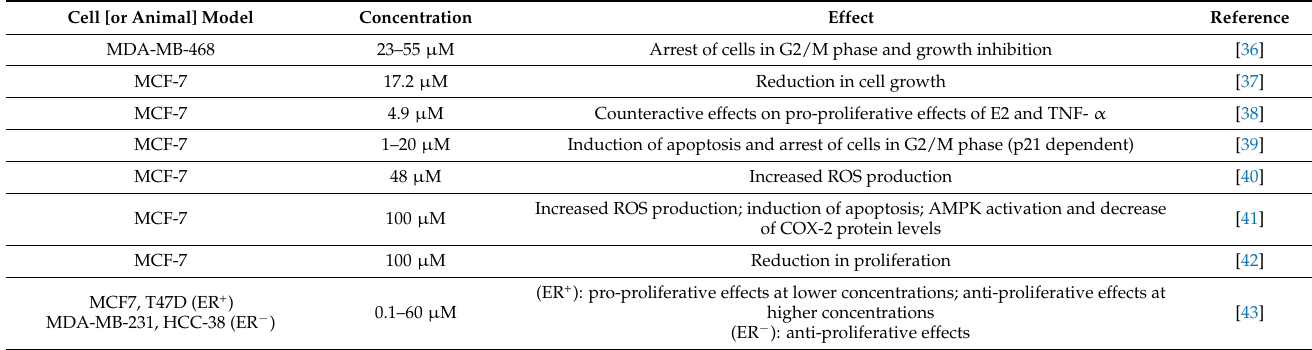
Table 1. Targets affected by quercetin free form in BC experimental